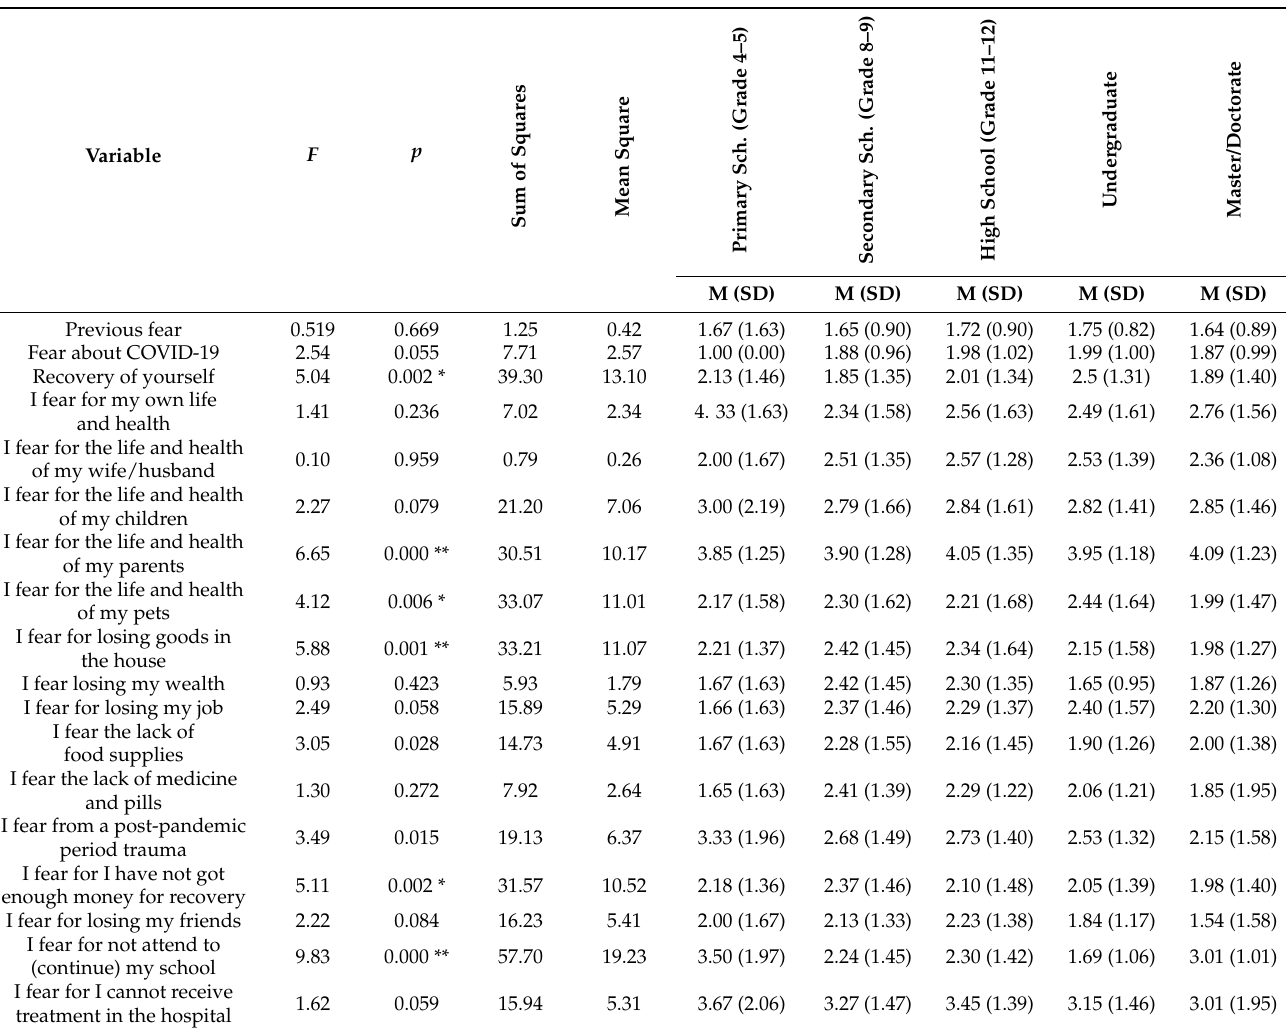
Table 4. One-way ANOVA results of the relations between the variables about fear caused by COVID-19 and education